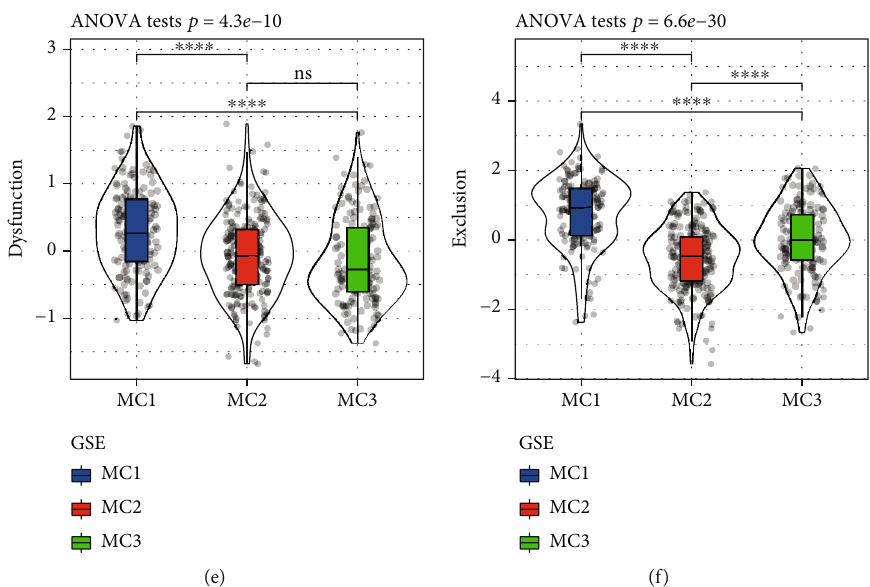
Figure 6: (a) TIDE score di ff erence among the metabolic subtypes of RNASeq. (b) T cell dysfunction score di ff erence among the metabolic subtypes of RNASeq. (c) T cell rejection score di ff erence among the metabolic subtypes of RNASeq. (d) GSE TIDE score di ff erence among the metabolic subtypes. (e) T cell dysfunction score di ff erence among the HCCDB18 metabolic subtypes. (f) T cell rejection score di ff erence among the GSE metabolic subtypes. (g) TIDE score di ff erence among the GSE metabolic subtypes. ANOVA test was conducted among three groups. ns: no signi fi cance. ∗∗ P < 0 : 01 , ∗∗∗ P < 0 : 001 , and ∗∗∗∗ P < 0 : 0001